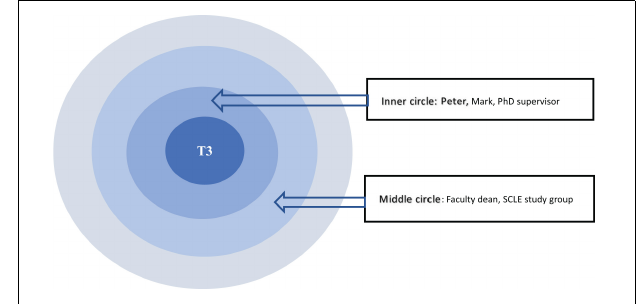
FIGURE 4 | T3’s CC